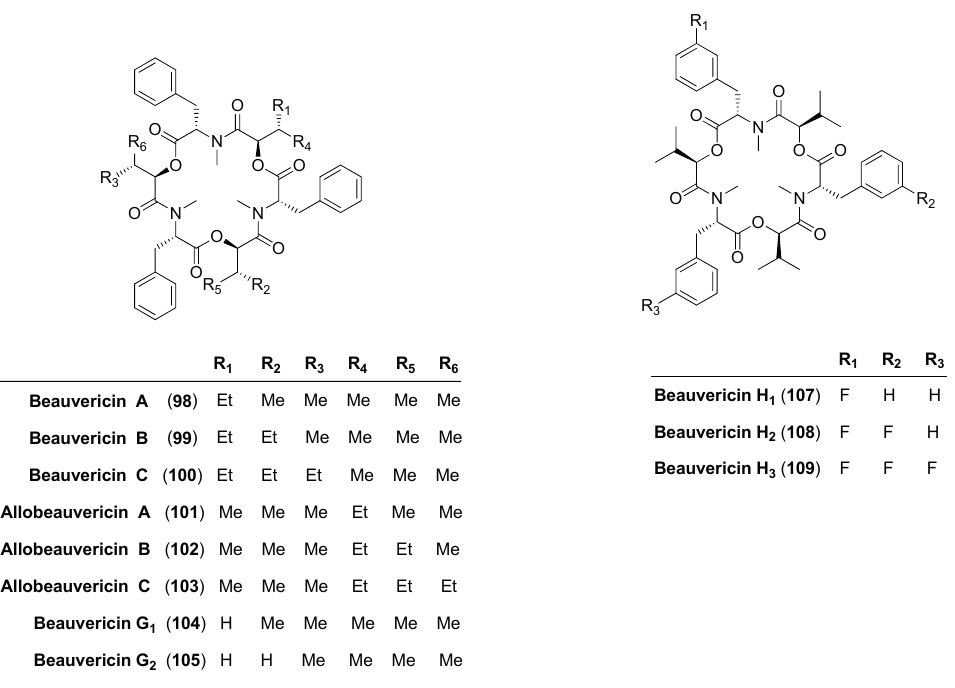
Figure 9. Derivatives 98 – 109 of beauvericin via